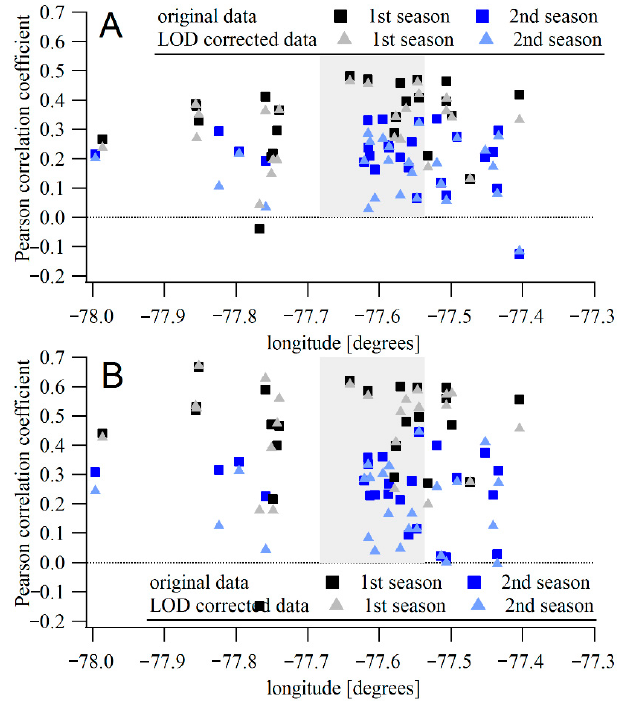
Figure 3. ( A ) Pearson correlation coefficient between hourly averaged concentrations measured by Speck units and TEOM located at the Rochester DEC site, dependent on the longitude of the Speck location (DEC site at − 77.55°). The gray area highlights the Rochester city center. ( B ) The same for daily averages.